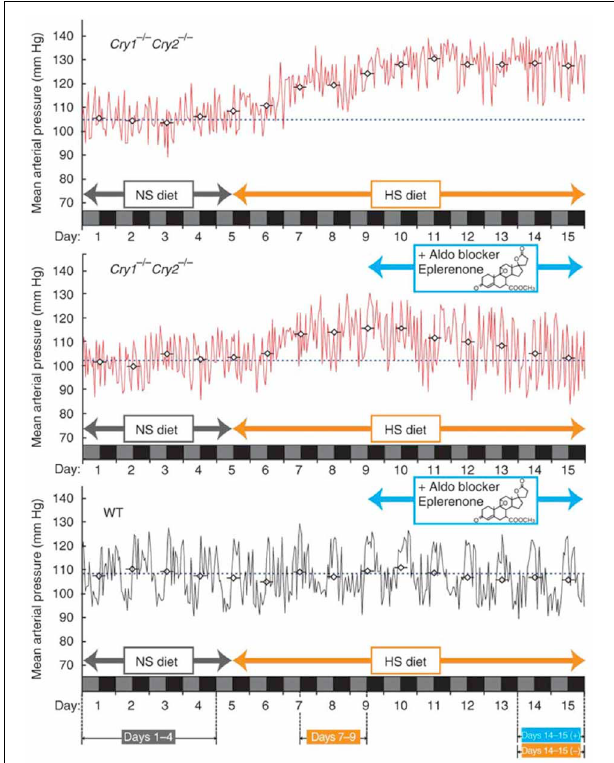
FIGURE 4 | Clock genes and hypertension. Fifteen-day mean arterial blood pressure recorded under high-salt diet conditions. Mice lacking the core clock components Cryptochrome1 ( Cry1 ) and Cryptochrome2 ( Cry2 ) ( Cry 1 − / − Cry 2 − / − , upper panel) show salt-sensitive hypertension, while the wild type (WT) doesn’t. This hypertension can be avoided with the aldosterone inhibitor, Eplerenone. The figures are adapted from Macmillan Publishers Ltd: Nature Medicine, Doi et al. (2010), copyright